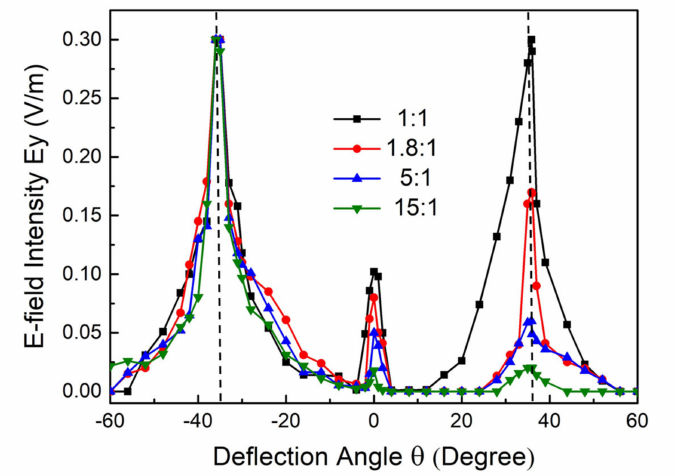
Figure 4. Electric field intensity of reflected waves. The vertical dashed lines denote the maximum values at ± 36 ◦ .